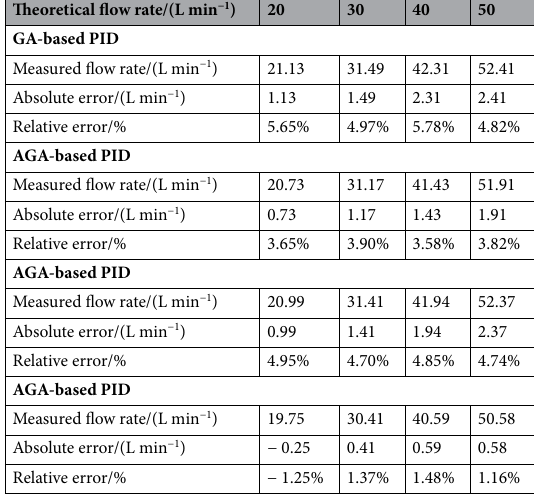
Table 3. System flow control